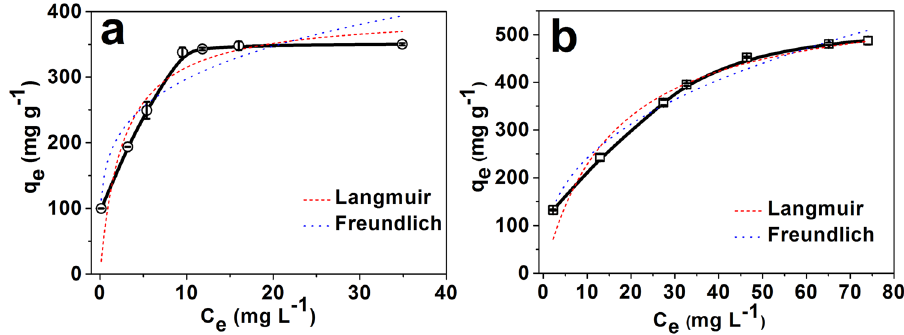
Figure 2. Adsorption isotherms of ( a ) 100 ppm BPA and ( b ) 250 ppm BPA at 25 °C and pH 8.0 for 60 min. Langmuir and Freundlich models were fitted to isotherms,